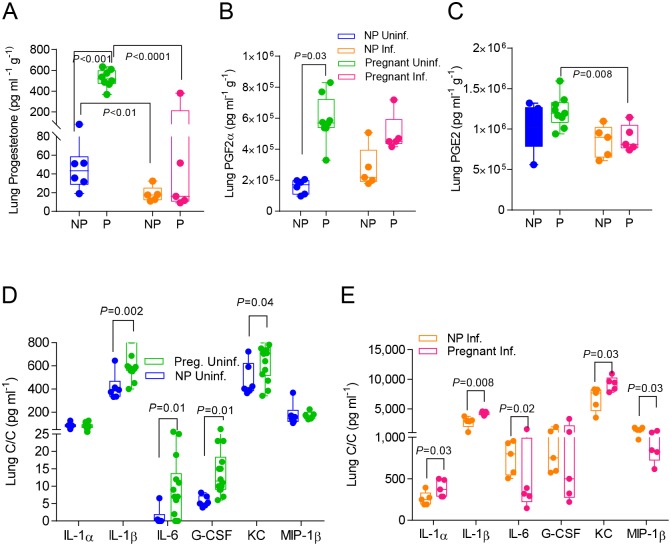
Pregnancy increases lung tissue expression of proinflammatory cytokines and chemokines while dampening the upregulation of progesterone and PGF2α following infection.Hormone expression in lung lysates was quantified via ELISA in uninfected (N = 6) and infected (N = 5) non-pregnant and pregnant mice for A. progesterone; B. prostaglandin F2α (PGF2α); and C. prostaglandin E2 (PGE2). Cytokine and chemokine expression in sera was quantified in lung lysates of D. uninfected pregnant (E16) (N = 8) and non-pregnant mice (N = 6); E. infected pregnant (4 d.p.i., E16) (N = 5) and non-pregnant mice (N = 5). Student’s t-test was performed between selected groups and significance noted above asterisk brackets. Abbreviations for groups are as described in Fig 3.